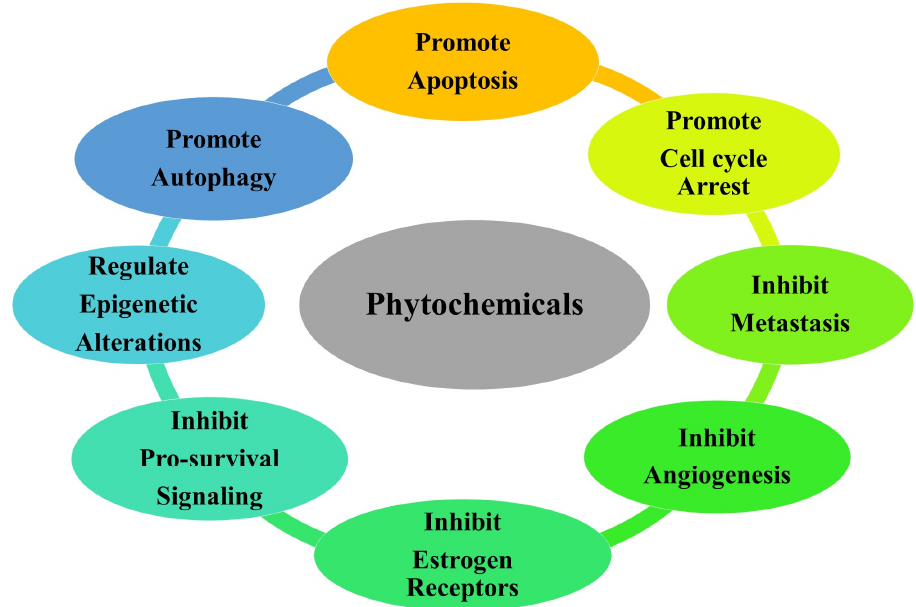
Figure 3. A schematic diagram representing the various functions of phytochemicals involved in the regulation of molecular pathways associated with cancer.